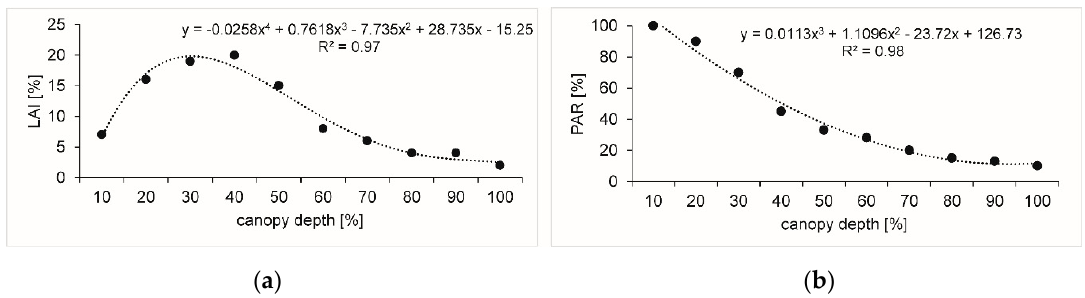
Figure 4. Relative distribution of LAI ( a ) and PAR dissipation ( b ) in relation to relative canopy depth; black dots—average values for all measured species, line-fitted model.